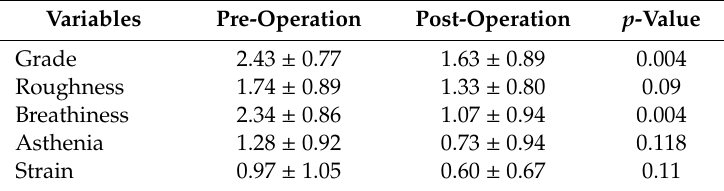
Table 2. Comparison of GRBAS between pre-OP and post-OP.